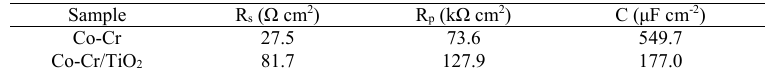
Table 4. The equivalent circuit parameters of Co-Cr and Co-Cr/TiO 2 coatings after 1 h immersion in Hanks’ solution